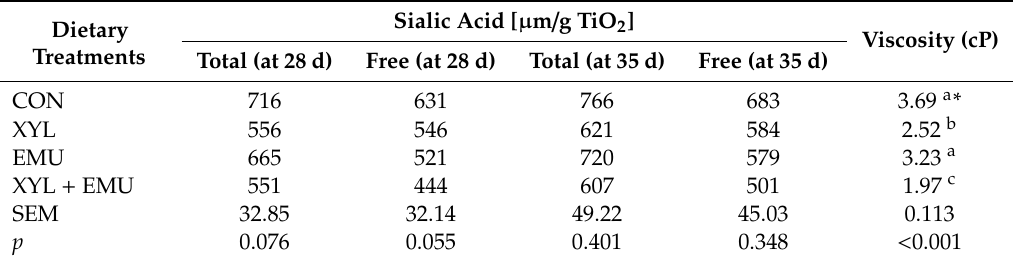
Table 3. Excretion of sialic acid in ileum and viscosity of digesta in birds fed control (CON), control supplemented with xylanase (XYL), control supplemented with an emulsifier (EMU), and control diet supplemented with xylanase and emulsifier XYL +